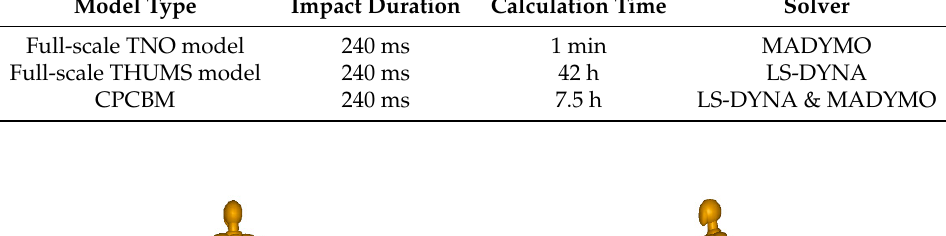
Figure 8. Head injury criterion 15 (HIC 15 ) recorded in the experiment and obtained from different human models in the simulatio